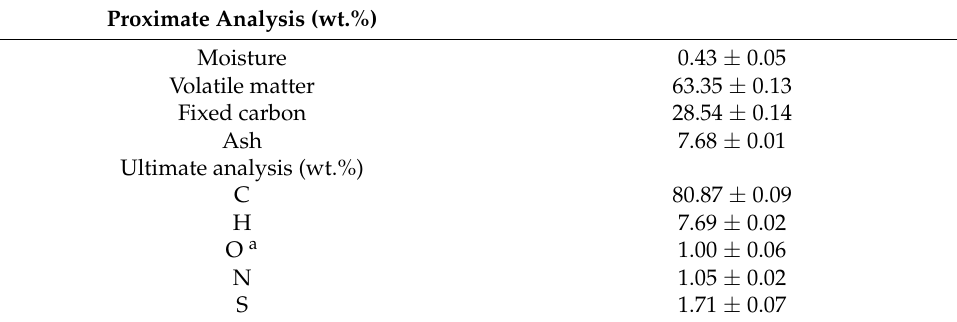
Table 7. Proximate and ultimate analysis of waste tire. Proximate Analysis (wt.%) Moisture Volatile matter Fixed